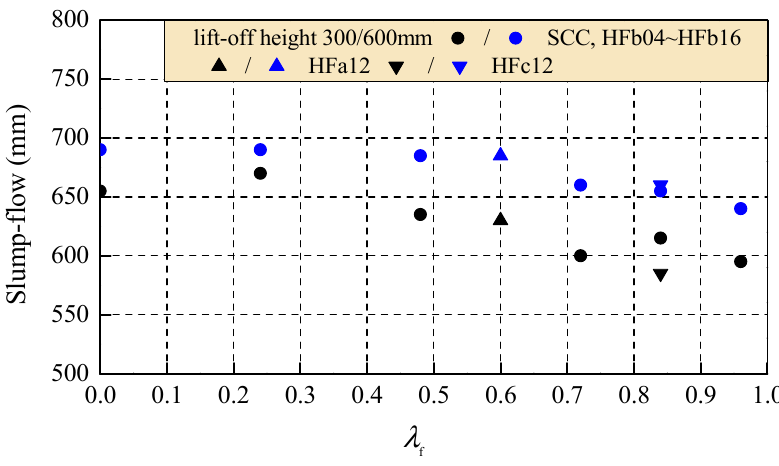
Figure 2. Slump-flow with different lift-off heights changed with the fiber factor. Compared to those with a lift-off height of 300 mm, the slump-flow with a lift-off height of 600 mm of fresh SCC enlarged 35 mm; and those of fresh self-compacting SFRC enlarged about 20–75 mm. This indicates the slump-flow was influenced by the kinetic potential during the lift-off. In the same 3 min period of lift-off time, the kinetic potential increased at a lift-off height of 600 mm compared to that at a lift-off height of 300 mm, and the slump-flow was increased. Meanwhile, a similar reduction in slump-flow existed with the increase in fiber factor at the two lift-off heights. This is due to the decrease in flowability of the fresh matrix with the enhanced bridge effect of steel fiber in the binder paste. As presented in Figure 3, compared to those with a lift-off height of 300 mm, the flow time T 500 and T final with a lift-off height of 600 mm of fresh SFRC was prolonged by about 1 and 6 s, respectively. The HFb16 presented a greater decrease in slump-flow with not much elongation in flow time. With the fiber length increased to be 34.8 mm, the slump-flow decreased, with the longest flow time of 6.7 s. No obvious relationship existed between flow time and fiber factor. This indicates that the rational mix proportion modified the flowability of fresh mixtures with the less blocking effect of steel fibers [25,26]. Generally, the dispersion of T 500 was smaller than that of T final . Therefore, T 500 is a rational index evaluating the filling ability of self-compacting SFRC.